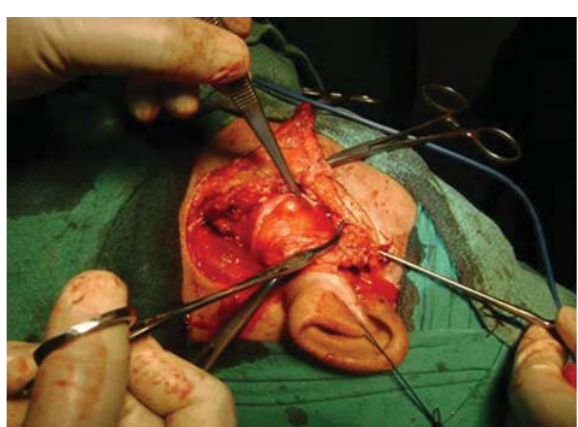
Superficial lobe of parotid